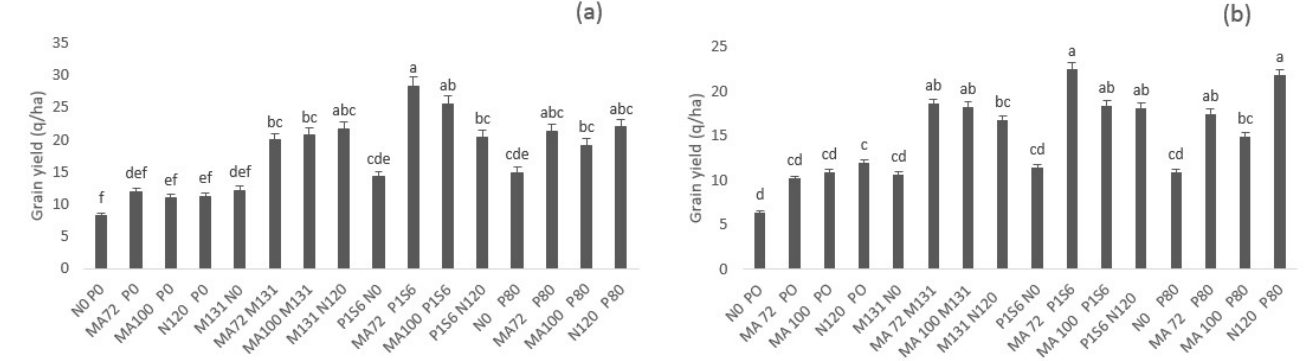
Figure 4. Effect of co-inoculation with Mesorhizobium spp. (MA72 or MA100) and Bacillus sp. (M131) or E. aerogenes (P1S6) and phosphate application combined to rhizobial inoculation on the grain yield of Chickpea in Merchouch ( a ) and Ain Sbit ( b ). Bars followed with the same letter are not significantly different at α = 0.05. (P80 indicate application of 80 kg P2O5/ha, N120 indicate application of 120 kg N /ha, N0 and P0 indicate no nitrogen and phosphate chemical fertilizers application).